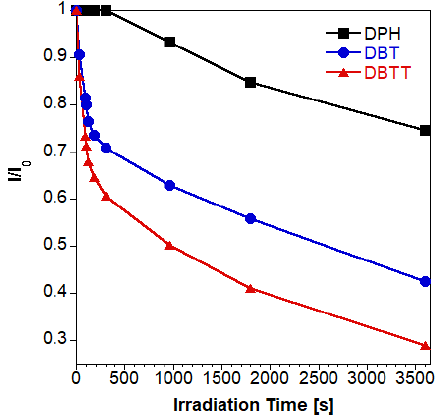
Figure 4. PL emission intensity ratios of the DPH (square), DBT (circle) and DBTT (triangle) compo- nents of the inclusion compounds in DCA, without any additives, as a function of UV light exposi- tion.